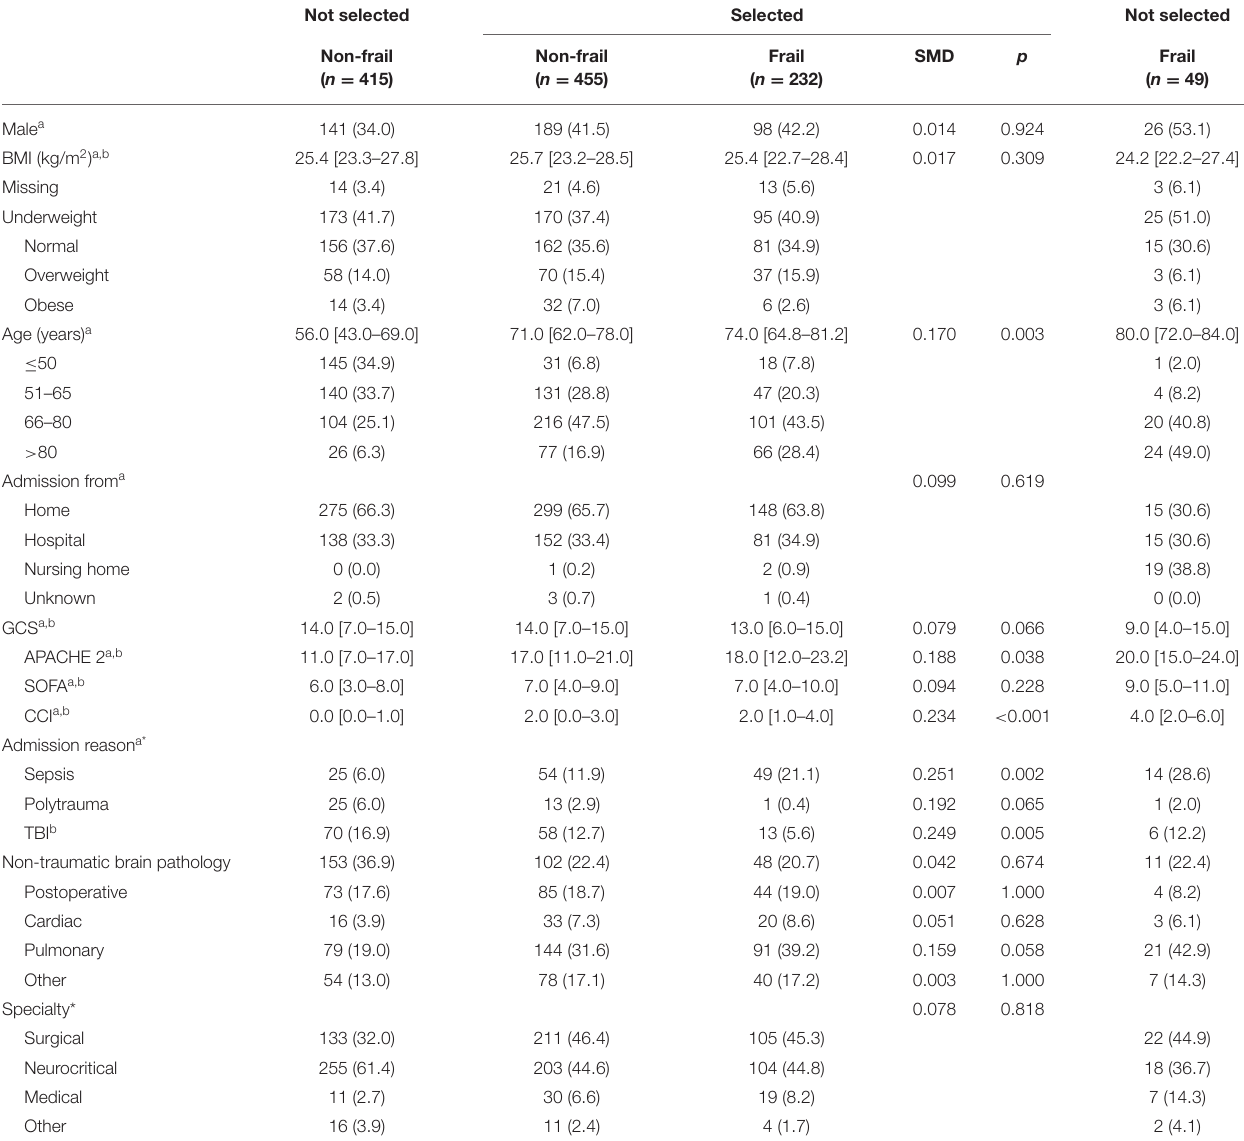
TABLE 2 | Characteristics of the propensity score-matched